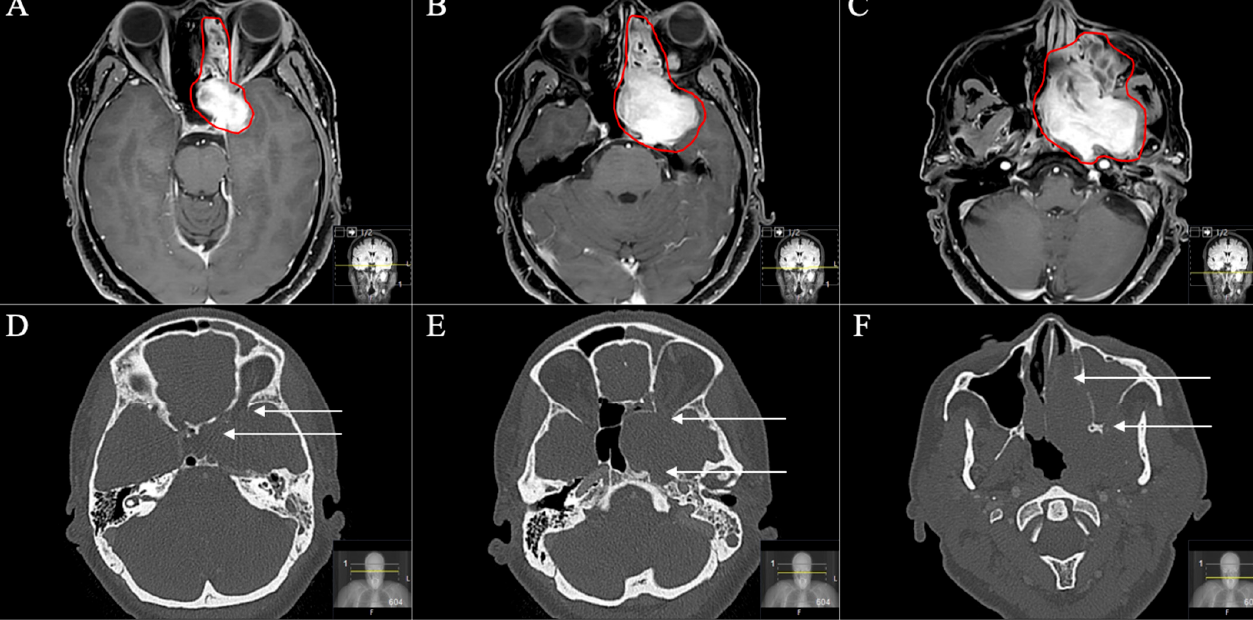
Figure 9. A 54-year-old female patient presented with slowly progressive visual impairment on the left side, trigeminal hypesthesia (V3) and an abducens nerve palsy with intermittent facial pain. ( A – C ) Preoperative axial T1-weighted gadolinium-enhanced MRI showing a massive space-occupying mainly extracranial trigeminal schwannoma (Type D) involving the middle fossa up to the orbital funnel. The schwannoma is bounded medially by the lamina papyracea, inferiorly by the hard palate and infiltrating the pterygopalatine fossa laterally. The middle nasal concha forms the anterior border. The paranasal sinuses are completely misplaced. ( D – F ) Preoperative axial CT scans demonstrating the destruction of the anterior skull base including the orbital funnel, the foramina ovale and rotundum and also the nasal septum and the maxillary sinus